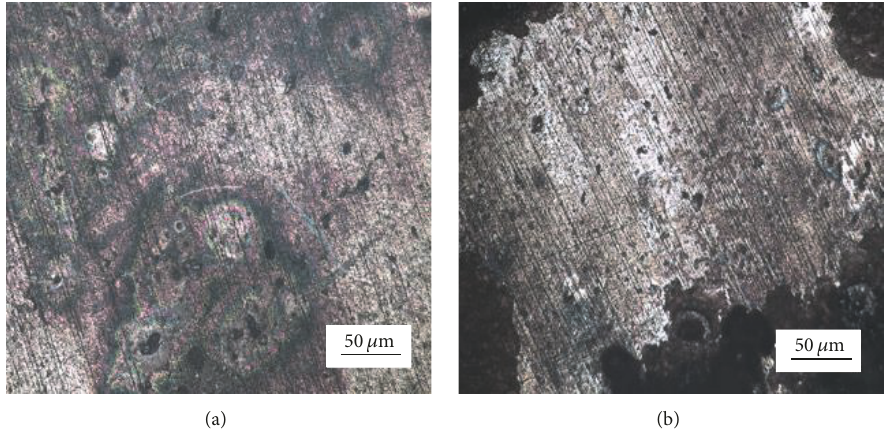
Figure 12: Macroscopic morphology of specimens of (a) BM and (b) WM, immersed in 3.5% NaCl solution for 7 days.